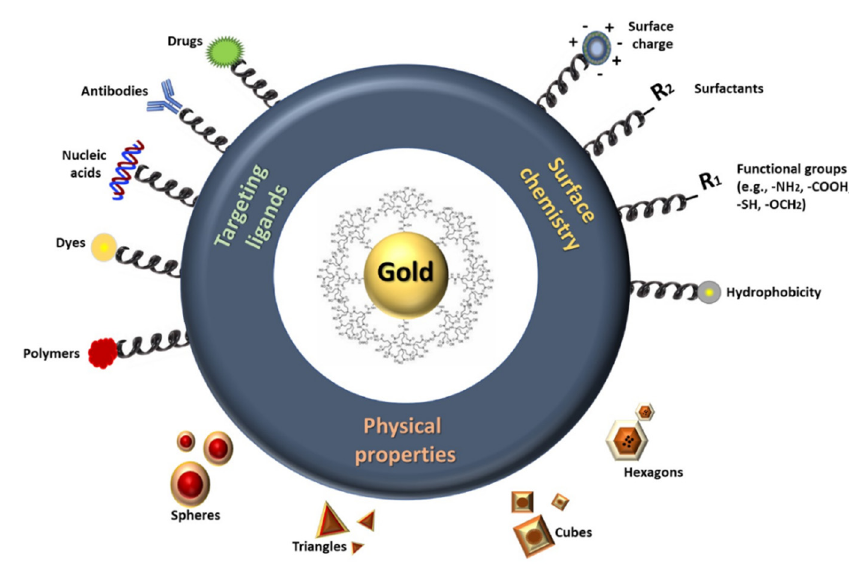
Figure 4. The structure of gold nanoparticles used in the treatment of